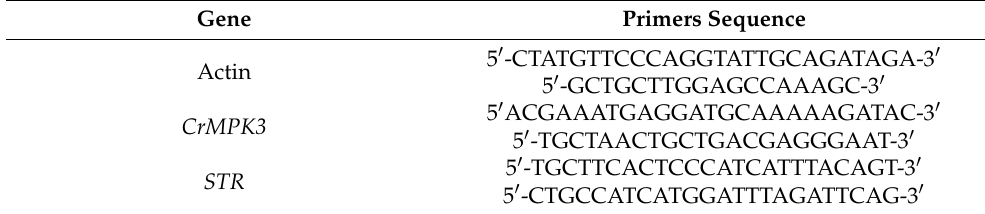
Table 2. List of primers used for qRT-PCR (5 (cid:48) –3 (cid:48) ). Gene Primers Sequence